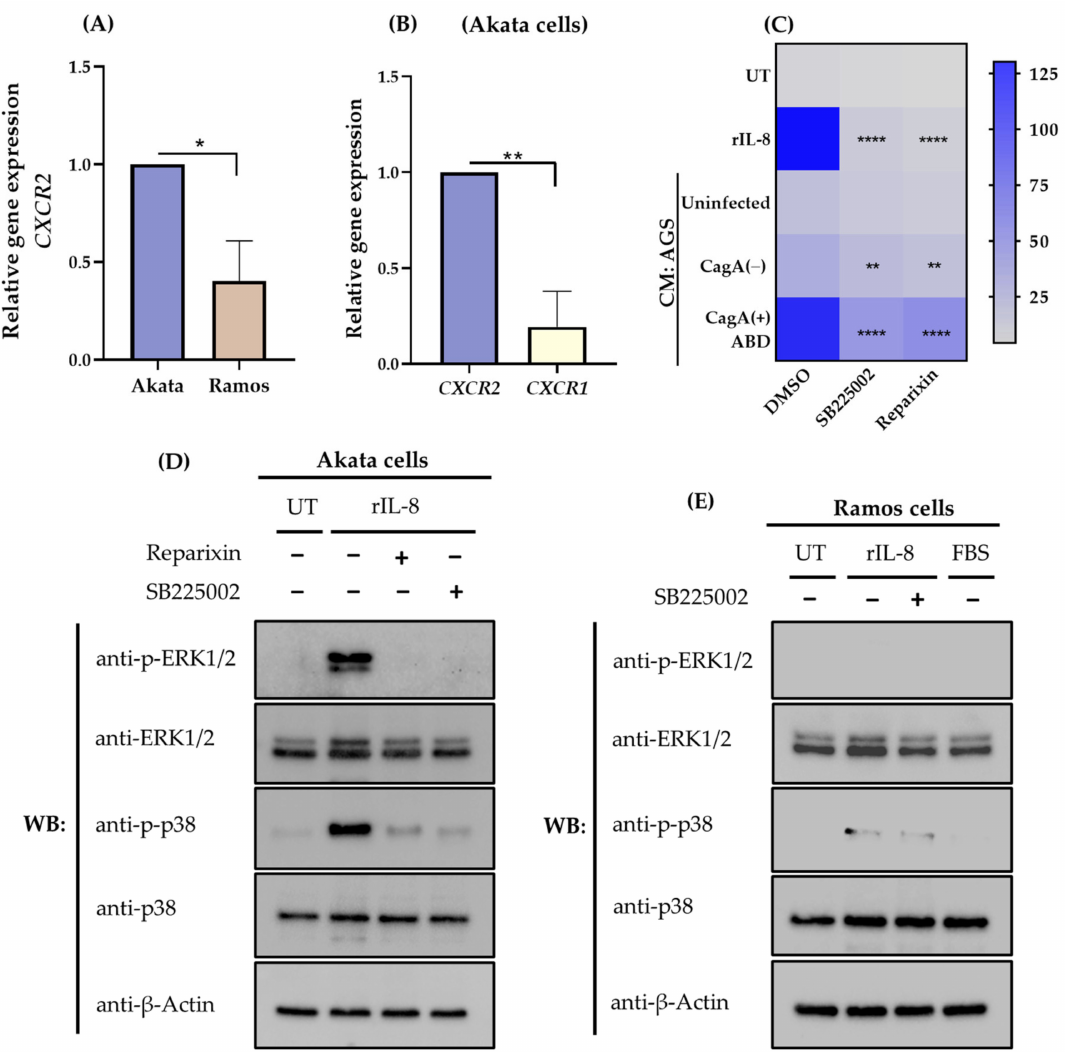
Figure 5. IL-8 promotes activation of ERK1/2 and p38MAPK mediated by CXCR2. ( A ) CXCR2 relative expression in Akata and Ramos cells in basal conditions. ( B ) CXCR1 and CXCR2 relative gene expression in Akata cells. Graphs represent the mean ± SEM of the relative gene or fold-change expression of three independent experiments. Expression values were normalized to GAPDH , and unpaired t-test was used to assess statistical significance between groups. ( C ) Heatmap of invading Akata cells chemoattracted by either the conditioned media from AGS cells infected with H. pylori CagA( − ) and CagA(+) ABD strains or rIL-8 (2200 pg/mL), with or without pretreatment with CXCR2 inhibitors (SB225002 and reparixin). Bar scale indicates the number of invading cells. Statistical differences were assessed comparing inhibitors versus vehicle (DMSO). A two-way ANOVA was used for multiple comparisons and a Tukey’s post hoc test. ( D , E ) Western blot analysis of phosphorylated p-ERK1/2, ERK1/2, p-p38MAPK, p38MAPK and β -Actin in Akata and Ramos cells treated or untreated (UT, control) with rIL-8 (2200 pg/mL), with or without pretreatment with the